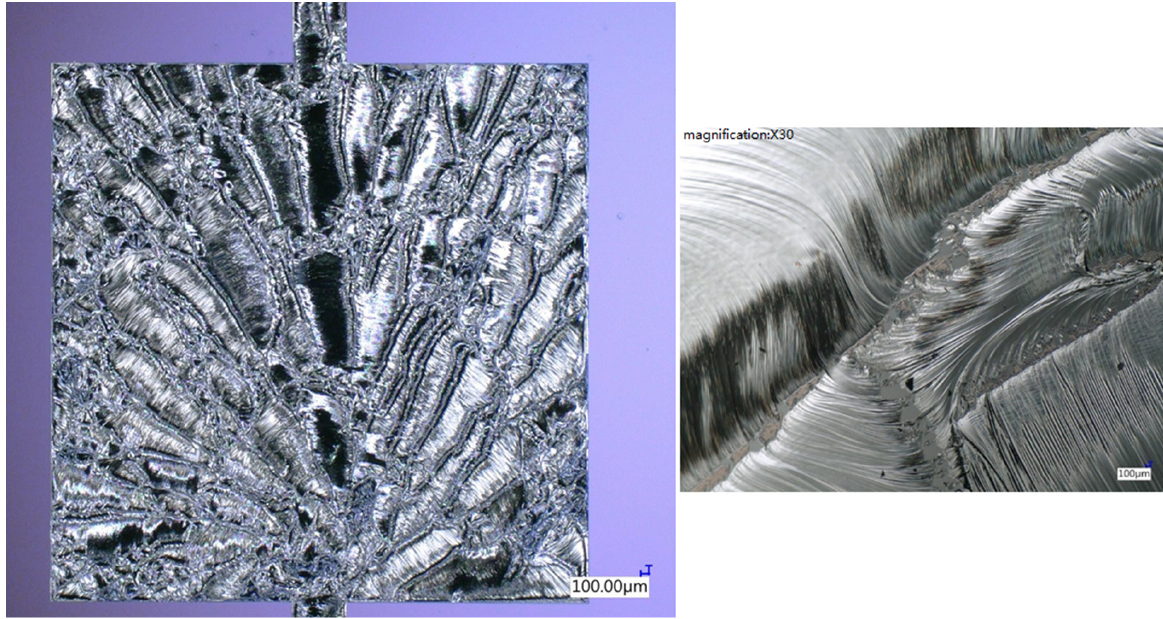
Figure 19. Optical microscopic image showing the microstructural morphology of the reacted Pd/Al-Ni/Al MS-iRMS. The right image is a magnified view depicting inter-dendritic regions formed during reaction